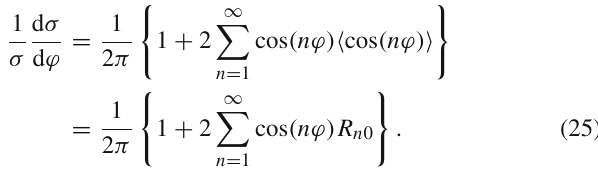
Fig. 6 BLM scales for the quarkonium-plus-jet (left) and the double quarkonium (right) production as functions of the rapidity separation, √ (cid:9) Y ,for C s = 13TeV.Predictionsfor J /ψ and ϒ emissions, 0 ,andfor described in terms of ZCW19 + FFs, are compared with configurations